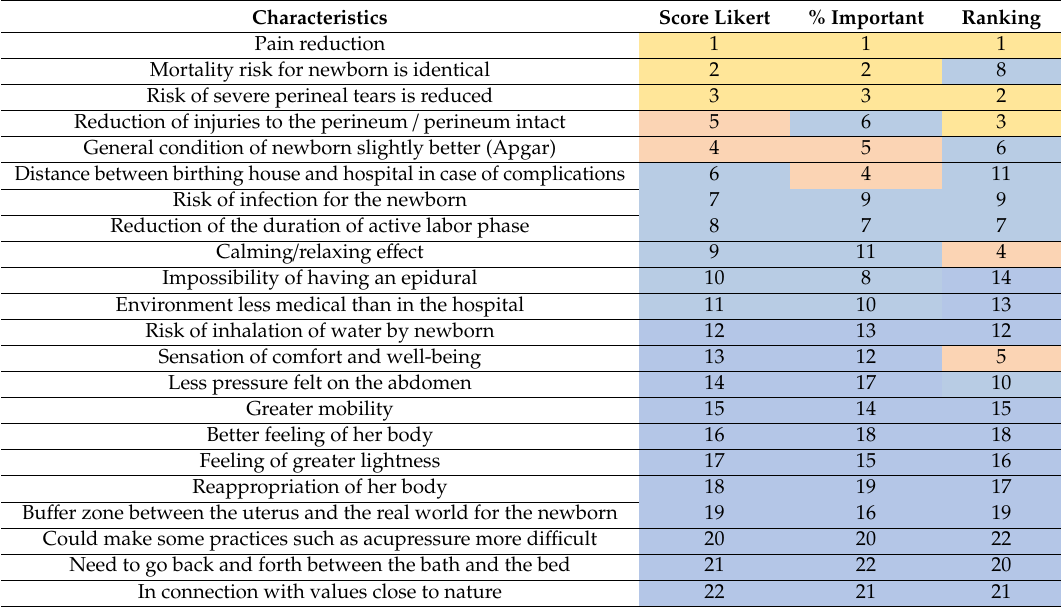
Table 2. Ranking of characteristics to make the choice to give birth in the